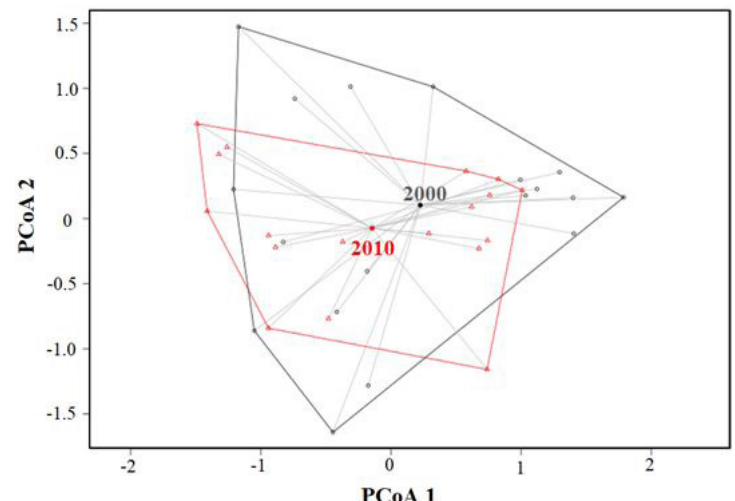
Figure 2. Dispersion of periods of drought and extreme flood (2000 and 2010) through PCoA (Principal Coordinate Analysis). The periods studied are identified by different